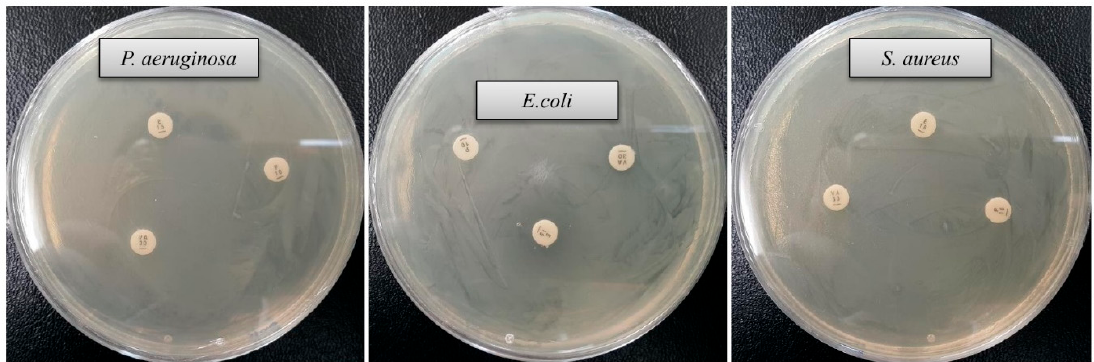
Figure 8. Antibacterial activity of commercial antibiotics against P. aeruginosa , E.coli and S. aureus . Abbreviations: P (penicillin G, 6 µ g / disc), E (erythromycin, 15 µ g / disc) and VA (vancomycin, 30 µ g / disc). Table 2. Antibacterial efficacy of green synthesized AgNPs against E.coli , P. aeruginosa and S. aureus .